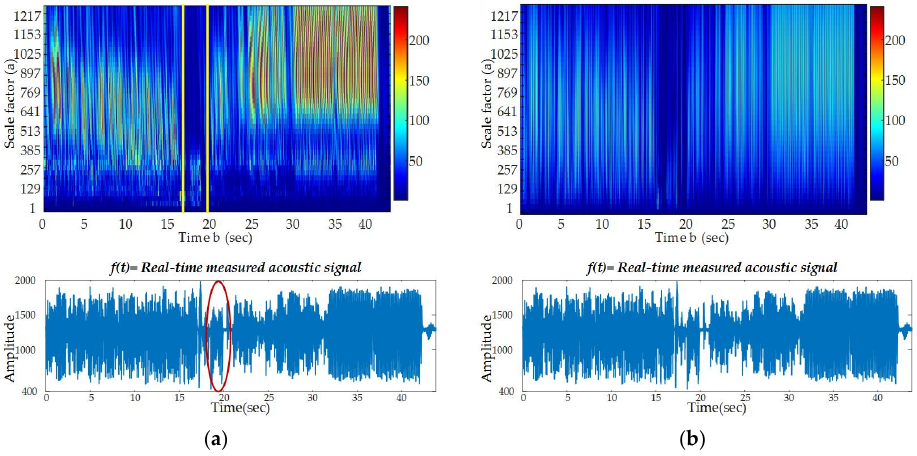
Figure 3. Localization scalogram of f(t) using ( a ) db12 “mother Wavelet” ( b ) “Haar” mother wavelet.